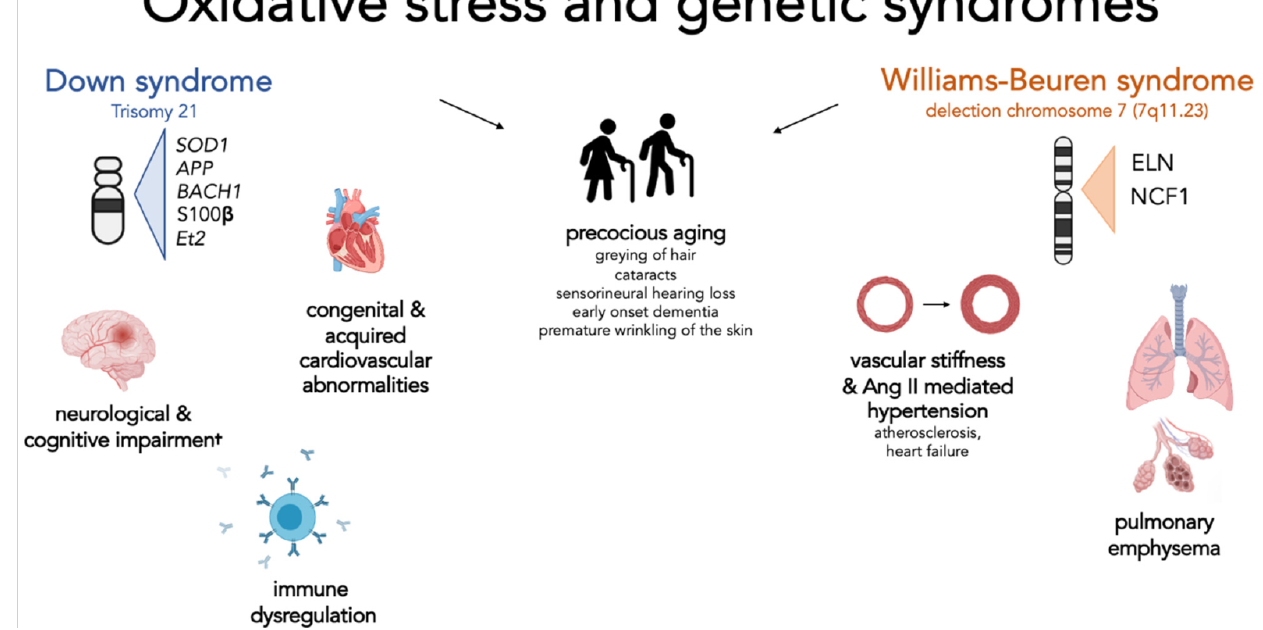
Figure 1. Oxidative stress and genetic syndrome, a focus on Down and Williams-Beuren syndromes. This figure summarizes for each syndrome the genes involved in the regulation of oxidative stress and the clinical manifestations that have been attributed to the effect of excessive oxidative stress. Interestingly, for both syndromes, a possible role of the indicated genes in directly or indirectly causing signs of premature ageing has been hypothesized. Down syndrome—Cognitive and neurological disorders: represent one of the main features of these patients: the overexpression of SOD1 and APP is associated with mitochondrial alterations, increased oxidative damage on neuronal cells, and early formation of senile plaques. Elevated expression of Ets-2 is associated with increased neuronal apoptosis. An abnormal production of BACH1 increases the risk of neurodegeneration. S100 β , when overexpressed, leads to increased production of ROS. Immune dysregulation: SOD1 plays a role in modifying the activity and response of T cells; Congenital and acquired cardiovascular abnormalities: although no specific gene has been identified, it seems that increased oxidative stress and mitochondrial dysfunction are associated with increased development of these complications. Williams-Beuren syndrome—vascular stiffness and Ang-II-mediated hypertension: Elastin haploinsufficiency is associated with the presence of increased vessel thickness and stiffness resulting in reduced lumen and increased pressure. These changes result in a physiological increase in angiotensin II and activation of NADPH. The subsequent level of oxidative stress and the response of the cell to the effect of angiotensin II depend on the number of copies of the NCF1 gene involved by the deletion; Pulmonary emphysema: